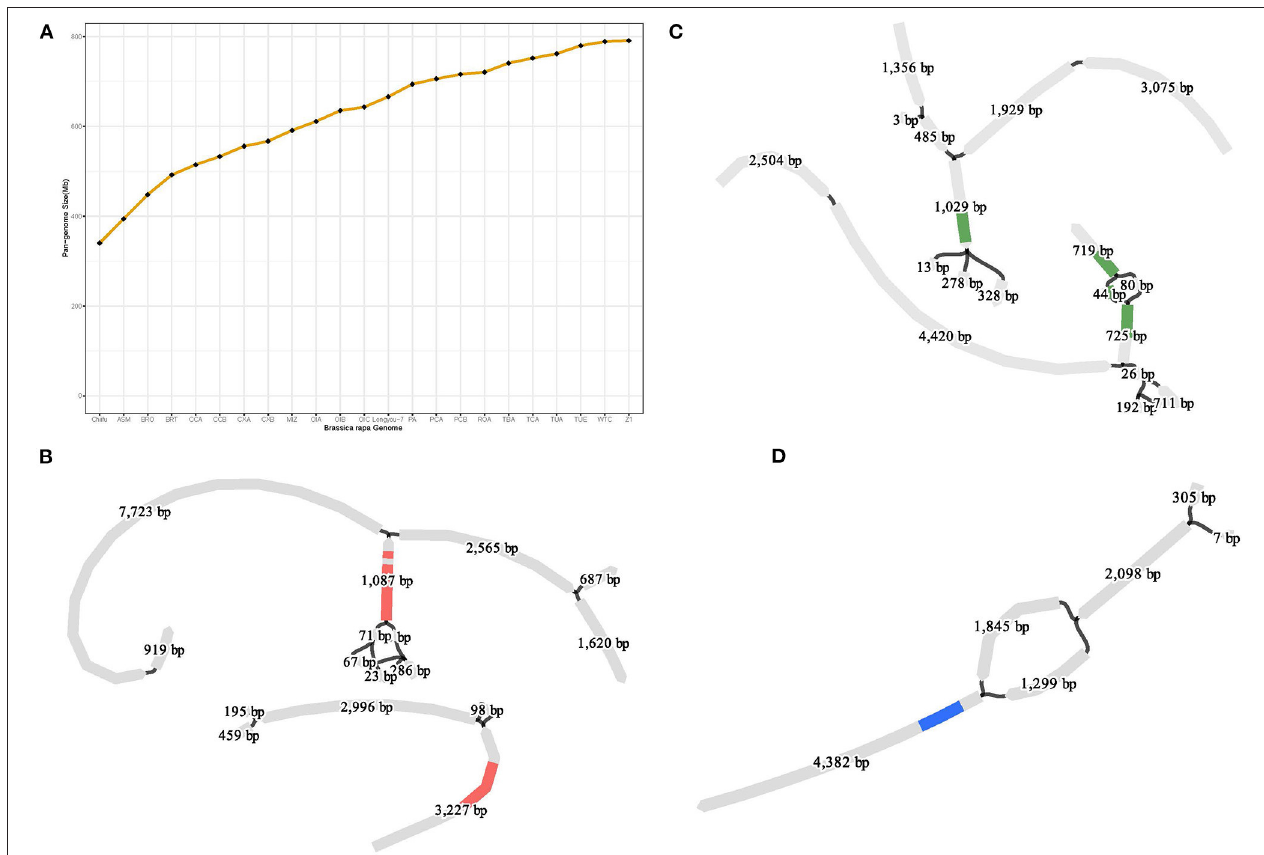
FIGURE 4 | Graph-based pan-genome constructed with 23 B. rapa genomes currently exist. (A) Pan-genome size increased with more genomes were used; (B) Two copies of gene TCP4 were detected in pan-genome and the SVs around them; (C) Two copies of the gene ERD10 detected in the pan-genome we constructed and the SVs located inside one of the copies (D) Structural variants detected in the pan-genome upstream of the gene ERF105 .